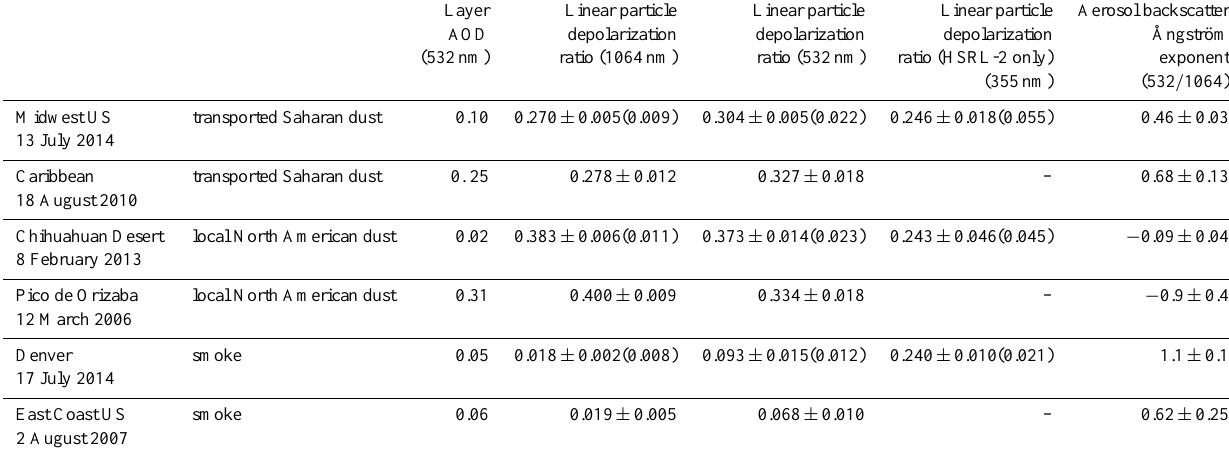
Figure 3. Curtains of aerosol backscatter and extinction coefficients from HSRL-2 for observations on 13 July 2014 for a flight segment in Missouri and Kansas in the midwestern United States. Table 1. Measured properties for specific dust and smoke samples. To obtain these values, samples were taken at specific times and altitudes comprising 400–4500 distinct measurement points. For the dust cases, values were chosen near the peak value of the 532nm particle depo- larization ratio, where it can be inferred that the aerosol is nearly pure dust. The values are reported as mean ± standard deviation for the sample. Systematic uncertainties for the particle depolarization ratio from HSRL-2 are indicated in